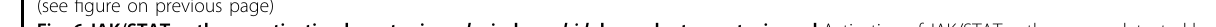
Fig. 6 JAK/STAT pathway activation by ectopic mahe induces hid dependent apoptosis. a – d Activation of JAK/STAT pathway was detected by 10X STAT92E-GFP reporter in eye-antennal discs. a , c Signi fi cant increase in GFP level was observed in GMR-GAL4 driven mahe eye antennal disc when compared to the reporter line alone, indicating activation of JAK/STAT signaling (compare area in rectangle). b , d DAPI was used to mark the nucleus. e – l Gain of function clone of mahe displays enhanced Stat92E activity. Gain of function clones of mahe using UAS-HA-mahe fl ies were generated with FLP/FRT system in salivary gland. f , j GFP positive and non-GFP cells mark mahe gain-of-function clones (marked with arrow) and wild-type cells (marked with arrowhead), respectively. e Level of Stat92E the transcription factor for JAK/STAT signaling was enhanced in mahe gain-of function somatic clones when compared to wild-type neighboring cells. i Clonal area marked with GFP positive cells, shows elevated level of Mahe in the gain-of-function clones. g , k DAPI was used to mark the nucleus. h , l Fourth column represents merged image with DAPI staining. m Graph represents Stat92E intensity per unit area which shows marked enhancement in the level of Stat92E in nucleus and cytoplasm, in mahe overexpressing clones when compared to neighboring cells. One-way ANOVA. n , n ′ Ectopic expression of mahe results in rough eye phenotype. o , o ′ and p , p ′ mahe induced rough eye phenotype was rescued by H99 and hid mutant, but not with rpr and grim mutants ( q , q ′ and r , r ′ ). s Real time PCR showed a threefold increase in hid transcript levels upon ectopic expression of mahe , while downregulation of JAK/STAT pathway by stat92E-RNAi rescued the hid levels. One-way ANOVA. Scale bar in 50 µm ( a – d , e – l ). Genotypes ( a , b ) w/ + ; 10X STAT-GFP/ + , GMR-GAL4/ + ( c , d ) w/ + ; 10X STAT-GFP/ + ; GMR-GAL4, UAS-HA-mahe/ + ( n ) w/ + ; + ; GMR-GAL4,UAS-HA-mahe/ + ( o ) w/ + ; + ; GMR-GAL4,UAS-HA-mahe/H99 ( p ) w/ + ; + ; GMR- GAL4,UAS-HA-mahe/hid 05014 ( q ) w/ + ; + ; GMR-GAL4,UAS-HA-mahe/rpr 87 ( r ) w/ + ; + ; GMR-GAL4,UAS-HA-mahe/grim C15E . One-way ANOVA * P < 0.05,